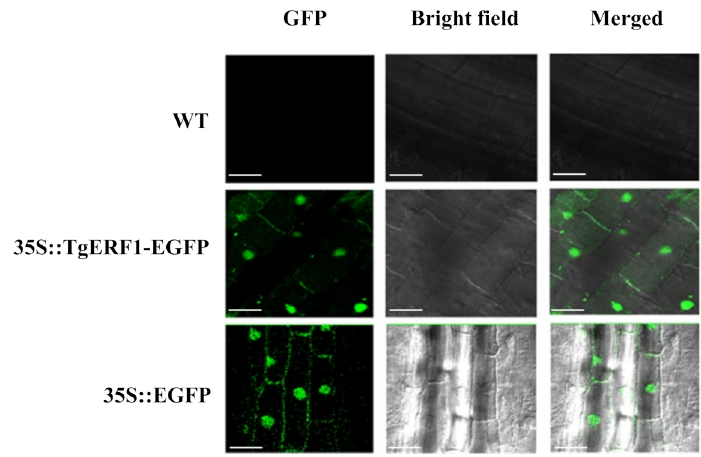
Figure 5. Subcellular localization of TgERF1::GFP protein in roots of transgenic tobacco seedlings. Cells from the root elongation zone of 7-day-old seedlings of a tobacco line were analyzed under Fluorescence Excitation (GFP), Bright Field, and Merge contrasting in a confocal microscope. WT root tissues without fluorescence; Transgenic line 35S::TgERF1- EGFP showing GFP fluorescence in the nucleus; Control line 35S::EGFP showing GFP fluorescence in the nucleus and cytoplasm. Bar: 30 µ m.